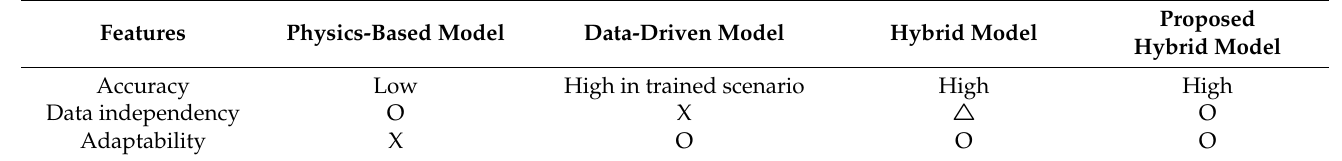
Table 1. Comparison of disaster prediction modeling